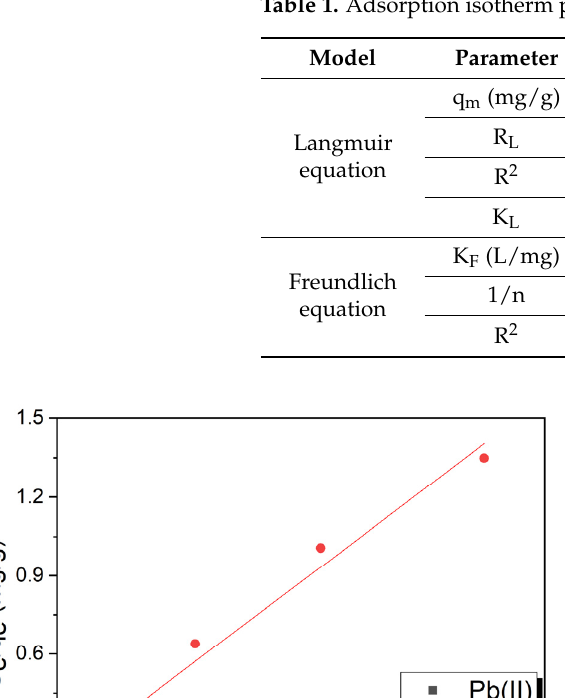
Table 1. Adsorption isotherm parameters of Pb(II), Cd(II), Zn(II), and Co(II) onto PVA-CS/CE.